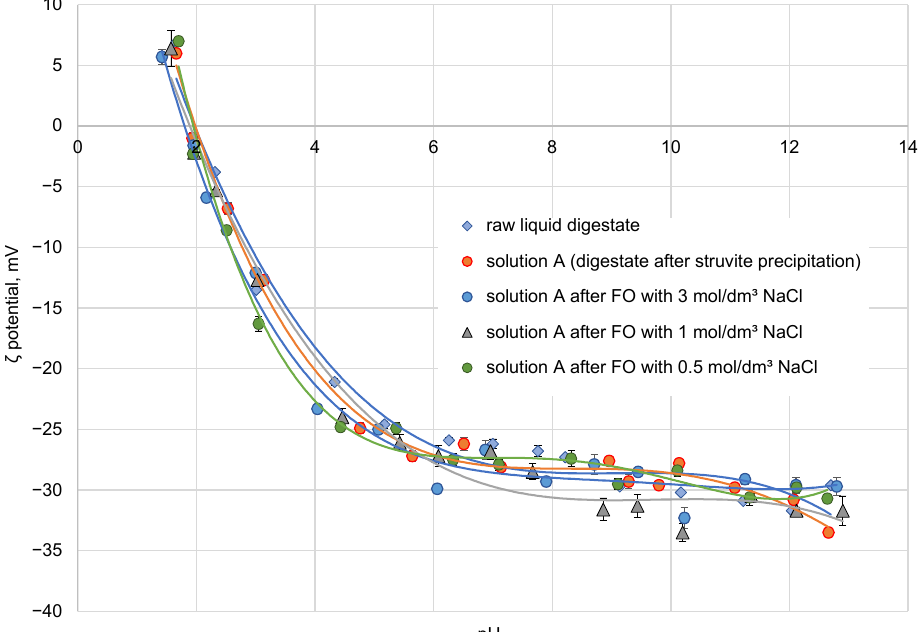
Figure 12. ζ potential of raw liquid digestate, digestate after struvite precipitation, and after FO with various NaCl concentrations in draw solution.